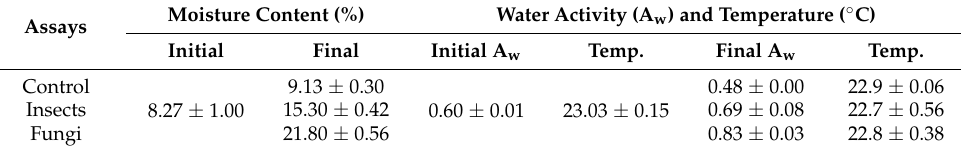
Table 1. Average initial and final moisture content (%) and water activity (A w ) values of different interaction assays ( n = 3) at room temperature at the moment of A w measurement (°C): control (containing only maize flour), insects (maize flour and Tribolium castaneum ), fungi (maize flour and Aspergillus flavus ).